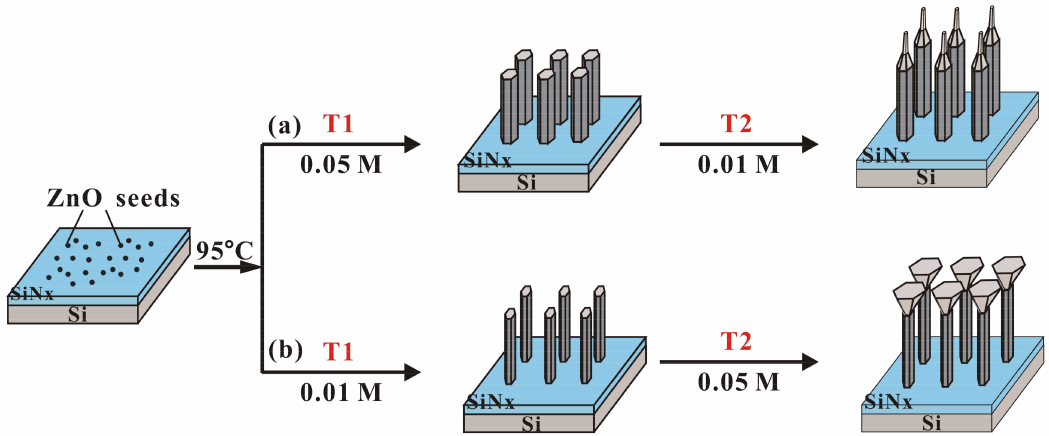
Figure 5. Schematic of the growth mechanisms of: ( a ) the syringe-shaped ZNAs; and ( b ) the nail-shaped